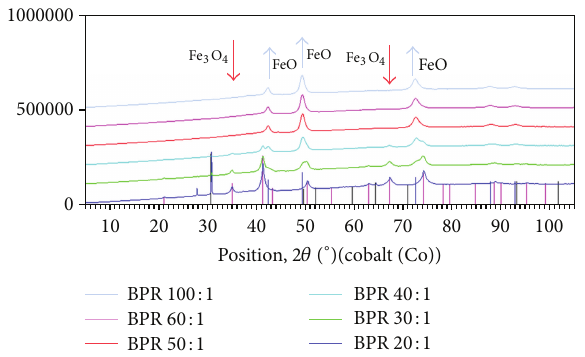
Figure 3: X-ray diffractograms of the ball-milled magnetite and graphite mixtures (1:3 mole ratio) at different ball to powder ratios (BPR), while rotational speed and milling periods were kept constant at 400rpm and 20 hours,